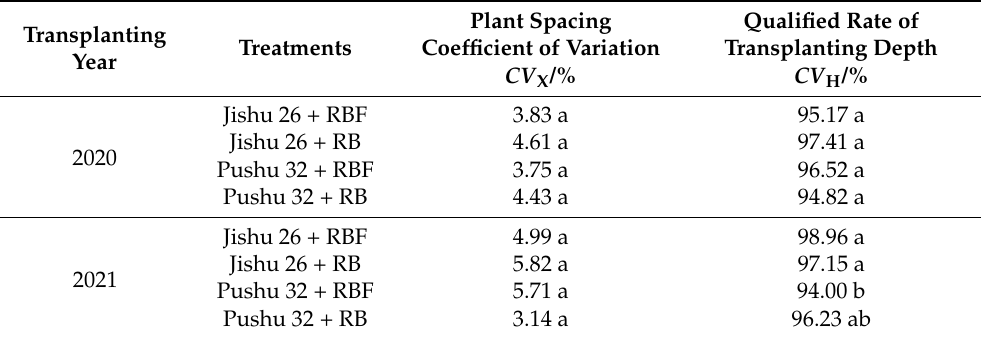
Table 2. Transplanting accuracy of the 2CGFS-2 compound sweet potato transplanter for two sweet potato cultivars under the RBF and RB cultivation systems in 2020 and 2021. Note: Means of the same year within a column followed by the same letters are not significantly different at p =